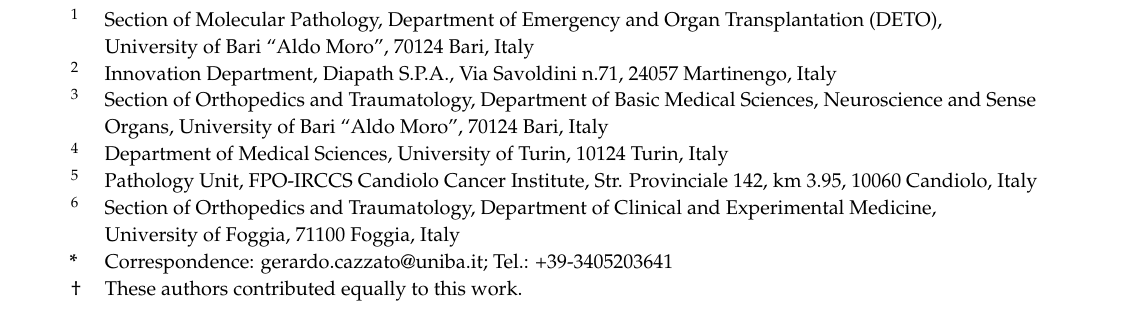
and/or neoplasms. Both total body CT and regional Magnetic Resonance highlighted the presence of an oval formation in the lateral belly of the brachial triceps, measuring 46 × 17 mm, with a mixed content including blood. The lesion seemed encapsulated, with some antero-external irregularities (Figure 1). At pre-operative angiography, intense peripheral vascularization was observed, without any apparent infiltration. Furthermore, PET scan showed areas of incremented radiopharmaceutical accumulation in the belly of the left brachial triceps muscle (SUV max 6.5). It was therefore decided to perform a first cytological aspiration with a fine needle, the results of which were constituted by blood material comprising numerous pigmented histiocyte/macrophage cells. Three months later, a biopsy was performed at the level of the lesion in question which, however, was not conclusive for any diagnosis. Following this report, it was decided to perform surgical removal of the formation and the finding was evaluated by the histopathologist.